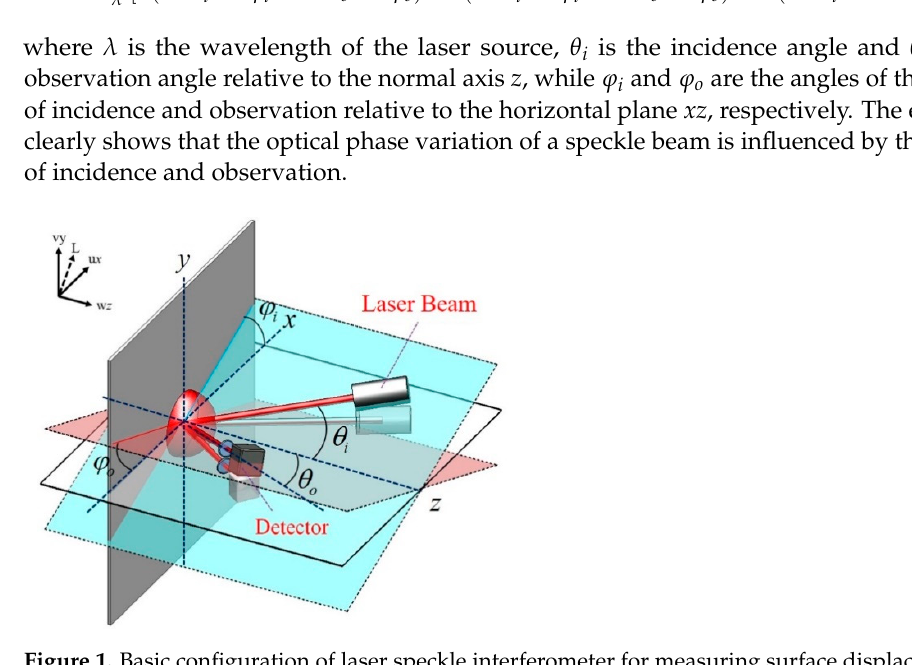
Figure 1. Basic configuration of laser speckle interferometer for measuring surface displacement.